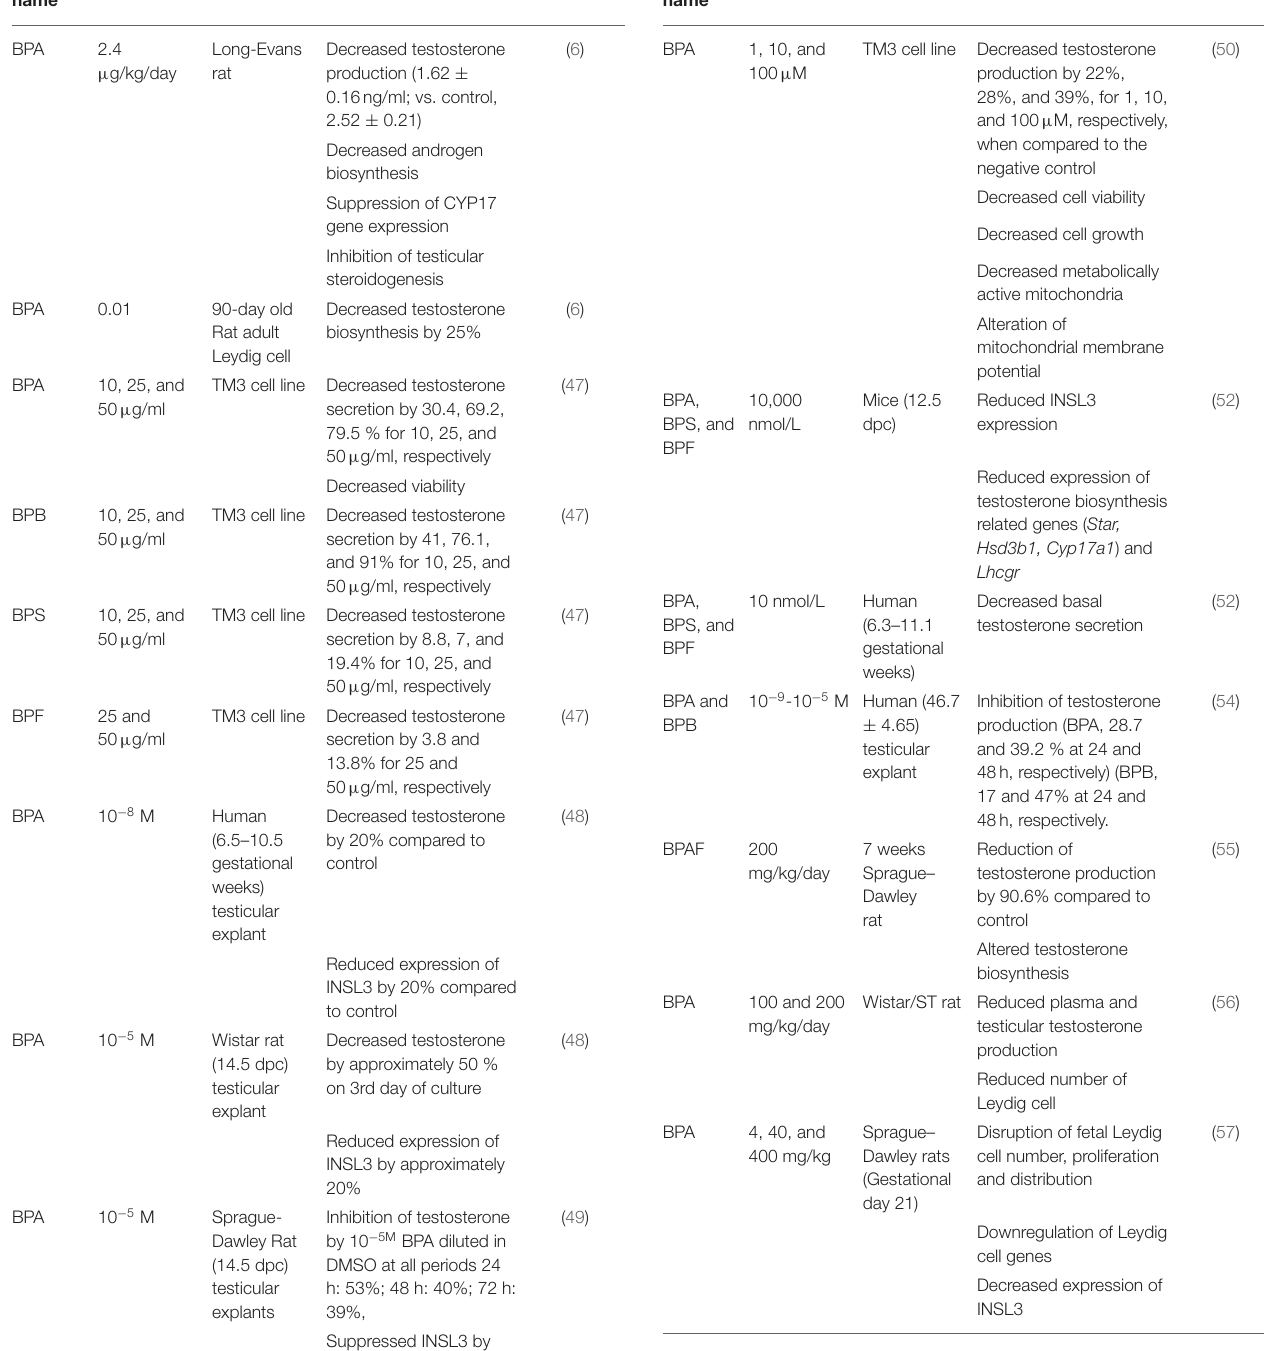
TABLE 1 | Effects of Bisphenols on Leydig cells.